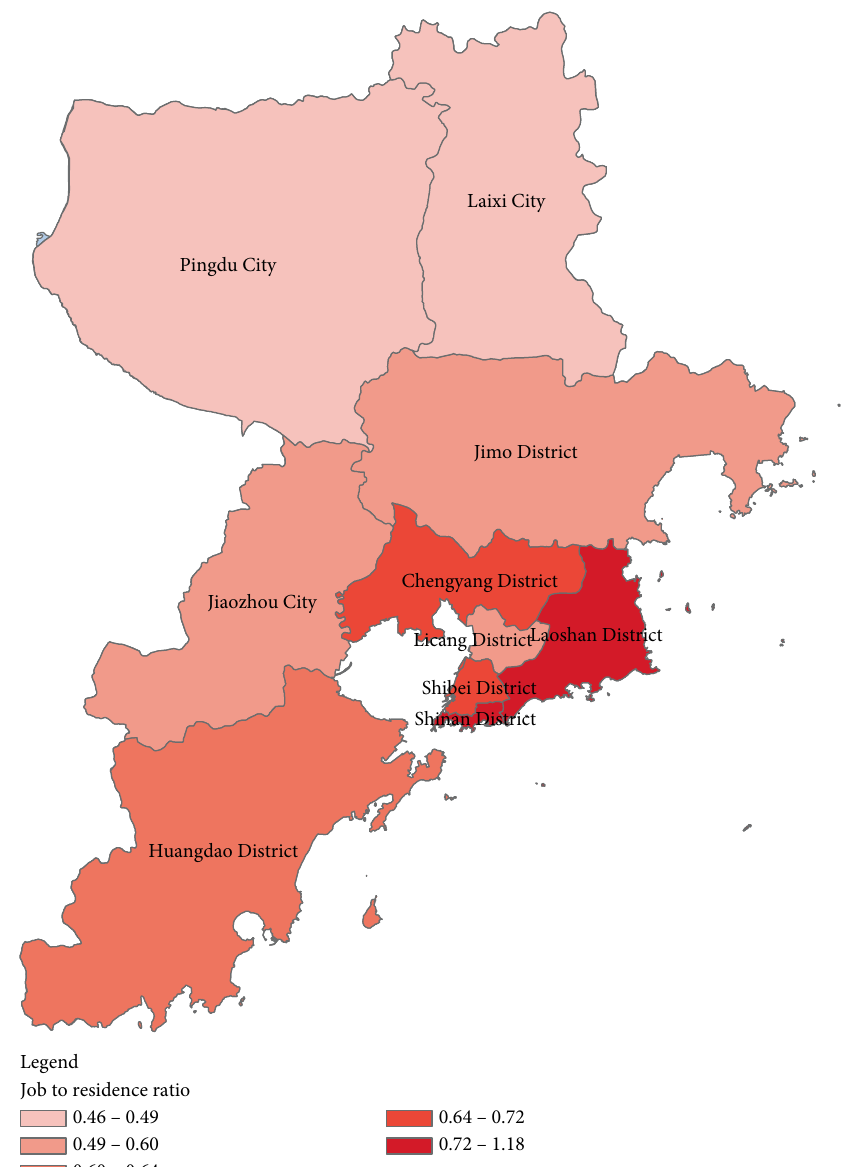
Figure 10: Distribution of job-housing ratio in